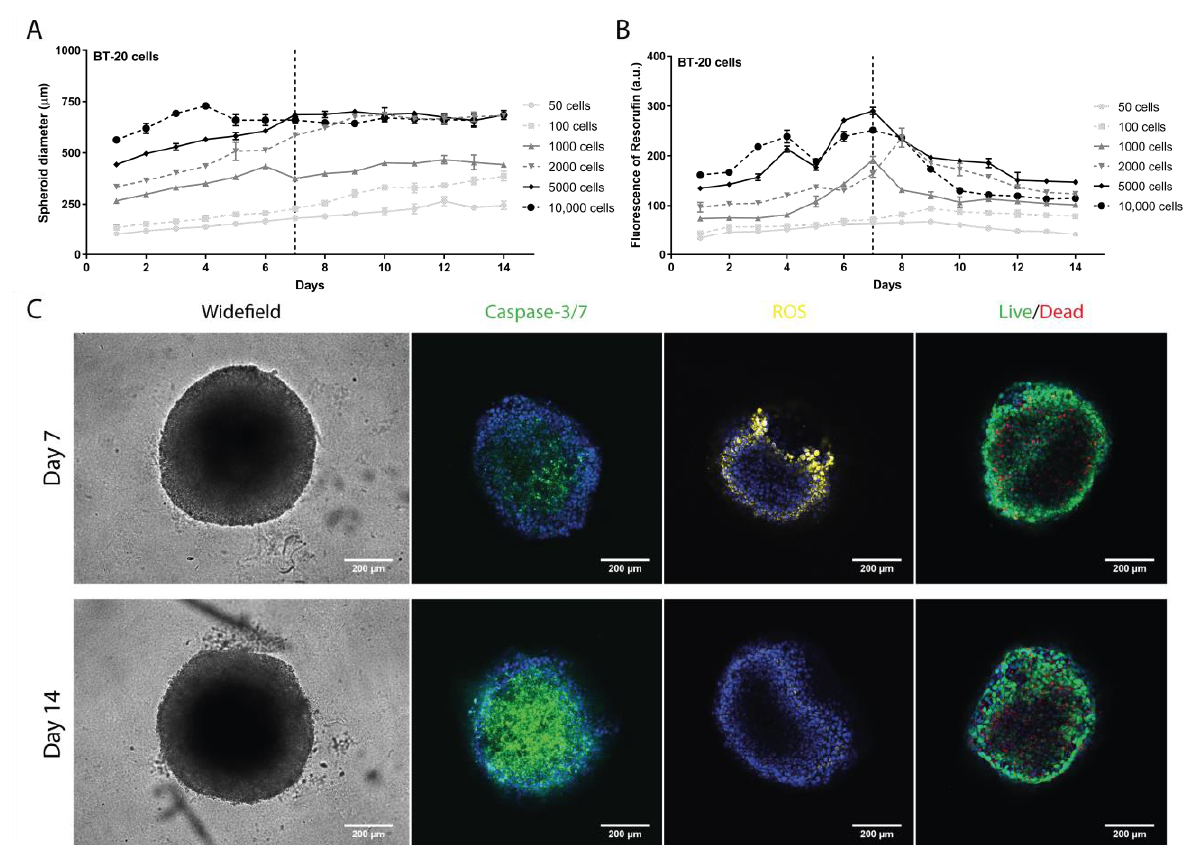
Figure 2. Evaluation of the BT-20 spheroid formation. ( A ) Spheroid diameter ( µ m) daily monitoring over 14 days measured with a widefield fluorescence microscope. ( B ) Spheroid cell metabolic activity daily evaluation over 14 days by measuring the fluorescence emission of resorufin with a microplate reader. ( C ) Representative images of parameters evaluated on days 7 and 14 at 5000 cells/well with a confocal point-scanning Zeiss LSM 880 microscope. In the apoptosis determination, apoptotic cells are marked in green; in the oxidative stress measurement, reactive oxygen species (ROS) are marked in yellow; and in the cell viability/mortality evaluation, intact cells (live) are marked in green and permeabilized cells (dead) in red. In all experiments, cell nucleus is marked in blue. Scale bar = 200 µ m. Graphs represent at least three biological repeats .